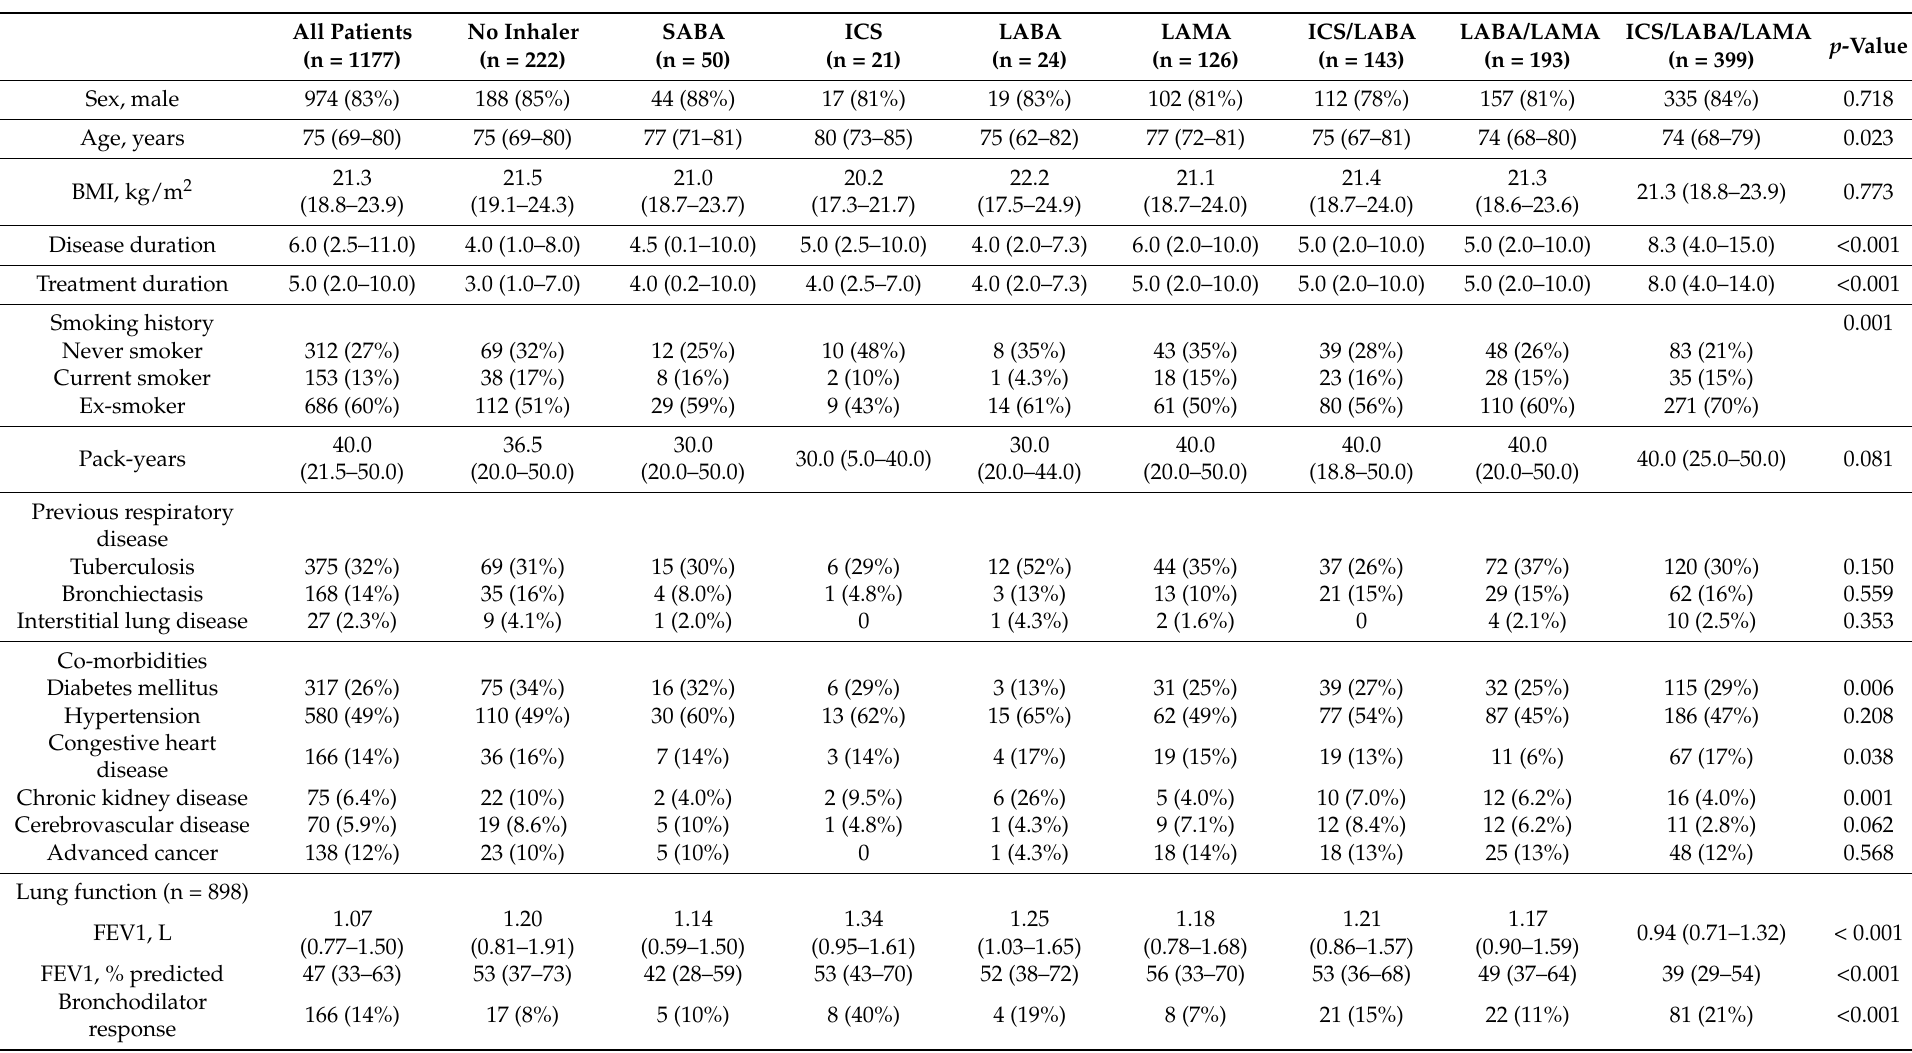
Table 1. Baseline demographic and clinical characteristics of patients with acute exacerbation of chronic respiratory disease according to type of